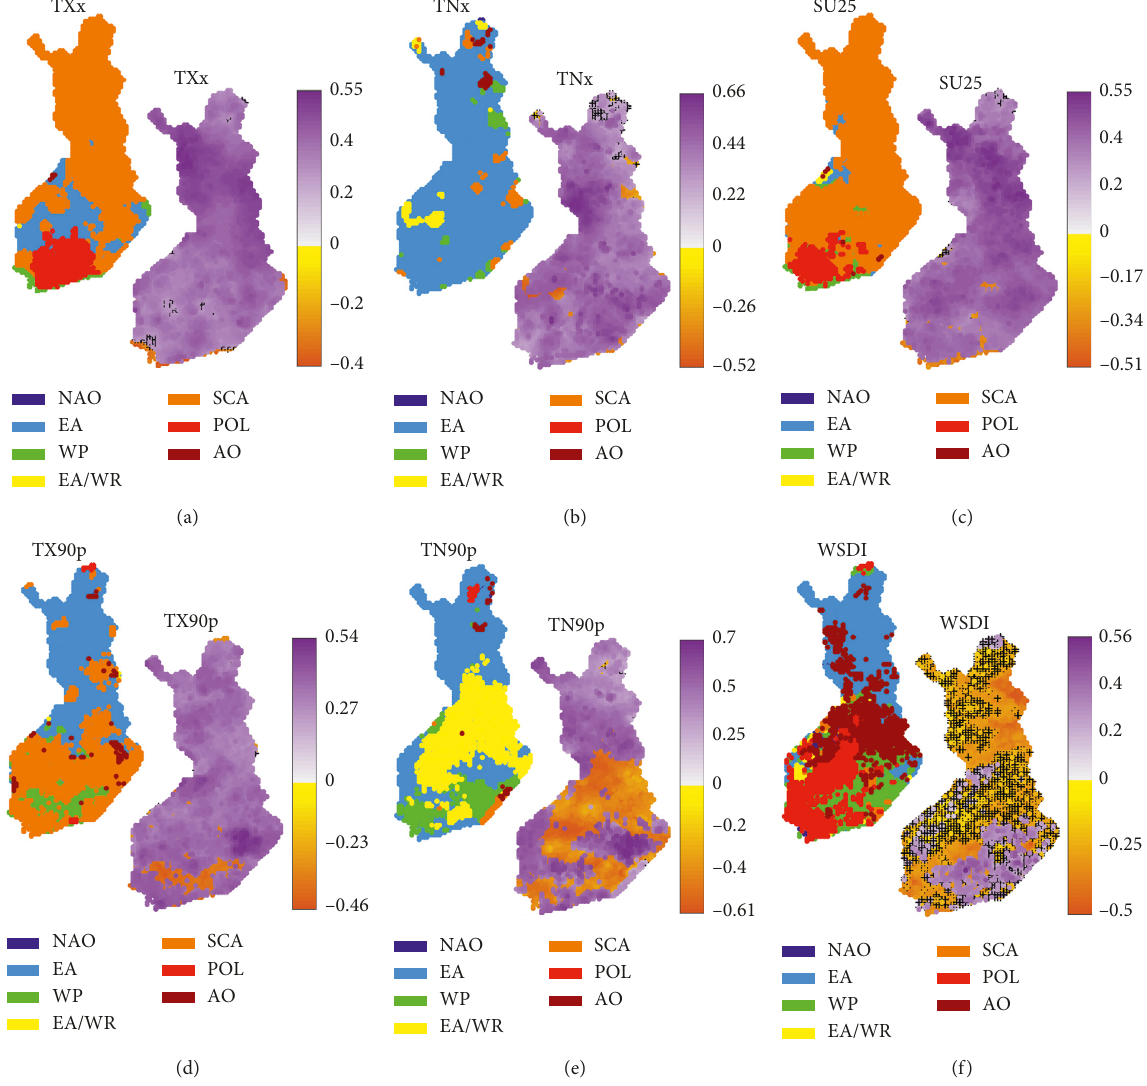
Figure 9: Spatial distribution maps of most influential NHTP (left) and its corresponding Spearman rank correlation (right) for warm extreme temperature indices including (a) TXx, (b) TNx, (c) SU25, (d) TX90p, (e) TN90p, and (f) WSDI in Finland during 1961–2011. The stippling indicates areas where the correlations are statistically insignificant ( p >